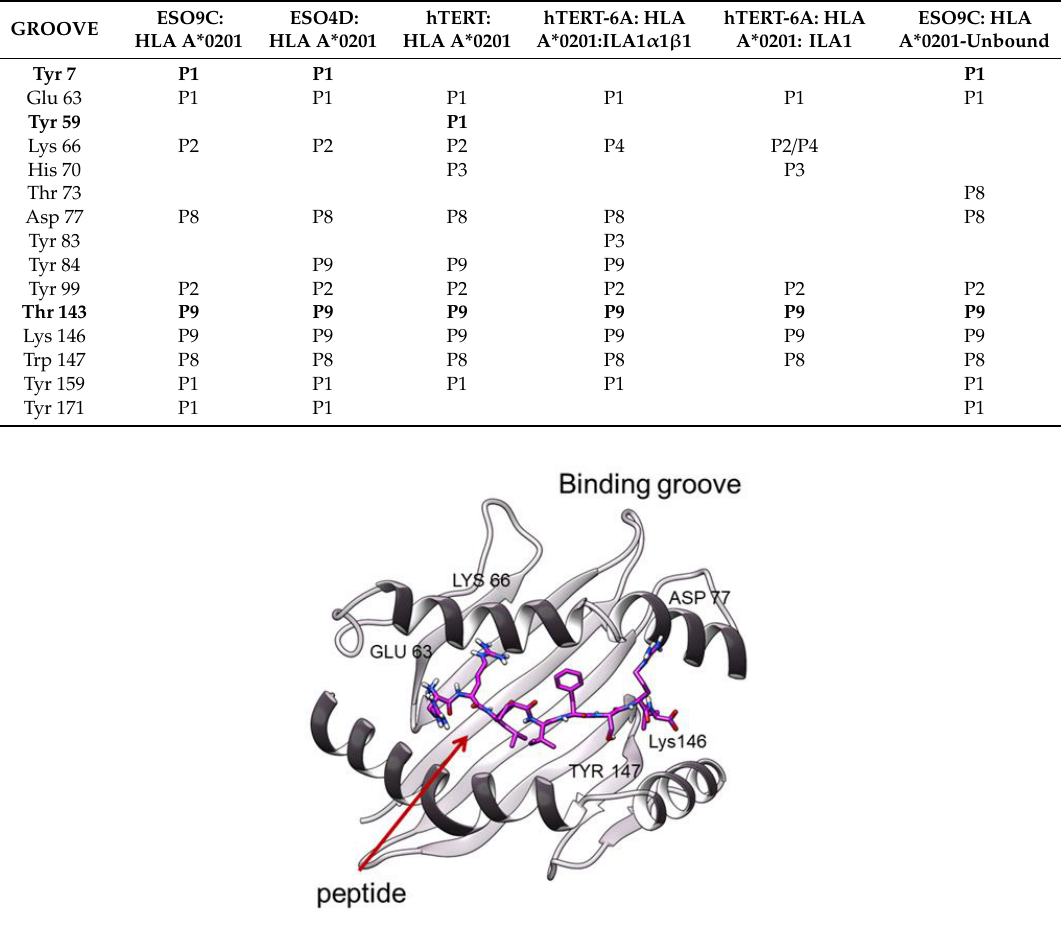
Figure 6. The Binding groove of a representative snapshot of 1G4-ESO9C. The residues making h-bonds are labelled.